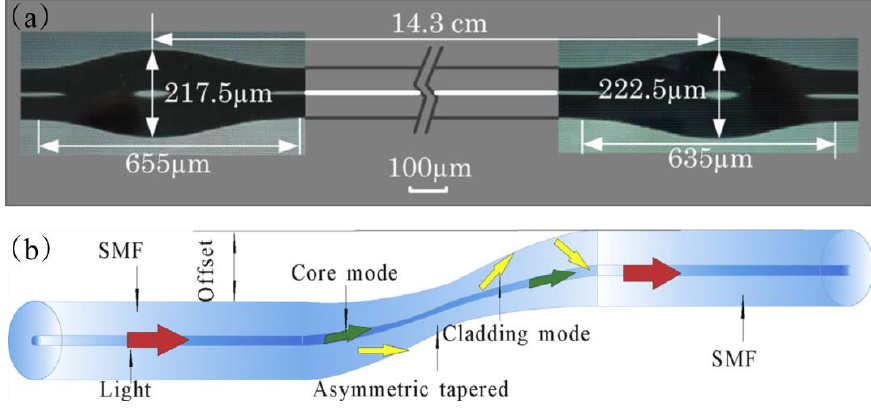
Figure 3. Schematic profiles of ( a ) Up-taper [54] and ( b ) S-taper [63].